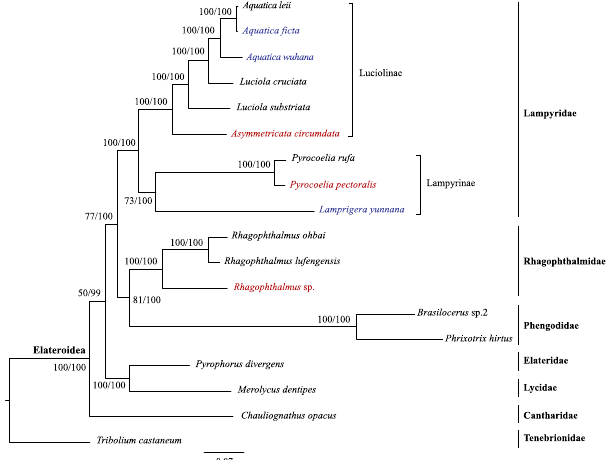
Figure 3. Phylogenetic relationships between Rhagophthalmidae and its related beetle families inferred from the concatenated 13 mitochondrial protein coding genes with the third codon positions removed. Numbers at nodes are the ML bootstrap values/Bayesian posterior probabilities, shown as percentages. Species shown in blue have mitochondrial genes generated from Sanger sequencing, while species in red have mitochondrial genes identified from Illumina-sequenced